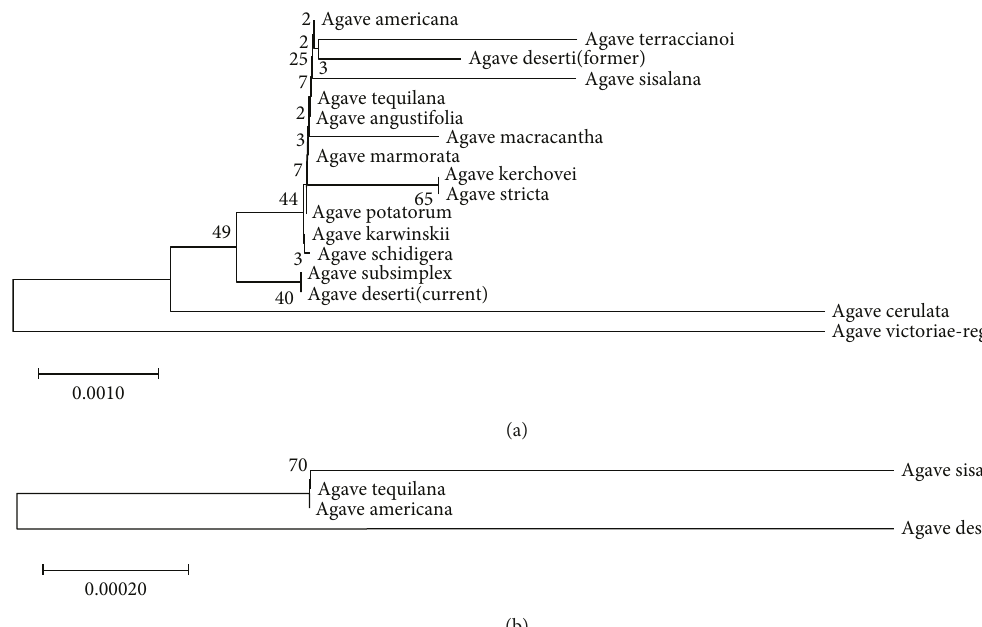
Figure 1: Phylogenetic analysis of chloroplast sequences in Agave species. (a) The trnL+trnL-trnF sequences (about 900bp) were used to construct a phylogenetic tree. (b) The sequences of A. tequilana (GAHU01110124), A. deserti (GAHT01022741), and A. americana (KX519714) were from NCBI. A. sisalana (CL7065.Contig2) sequence and the other 13 sequences were from previous studies [15, 24]. Table 1: Summary of the transcriptomes for the 3 Agave species.